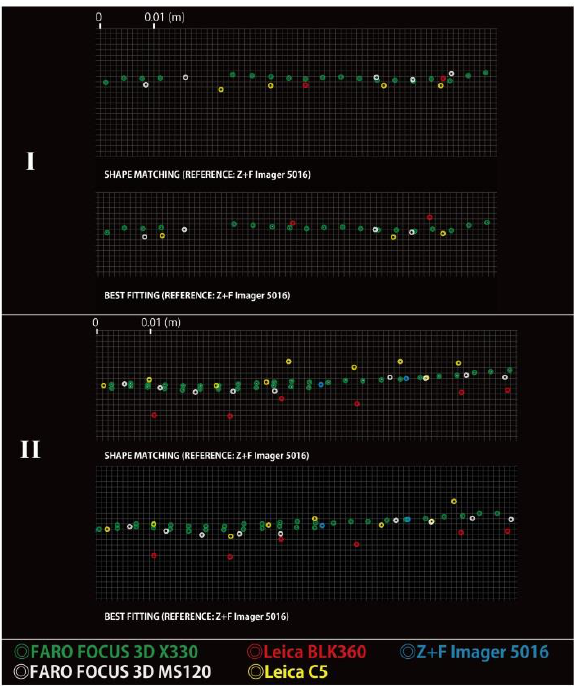
Figure 13: Alignments of Point Clouds (Refference:Leica BLK360)